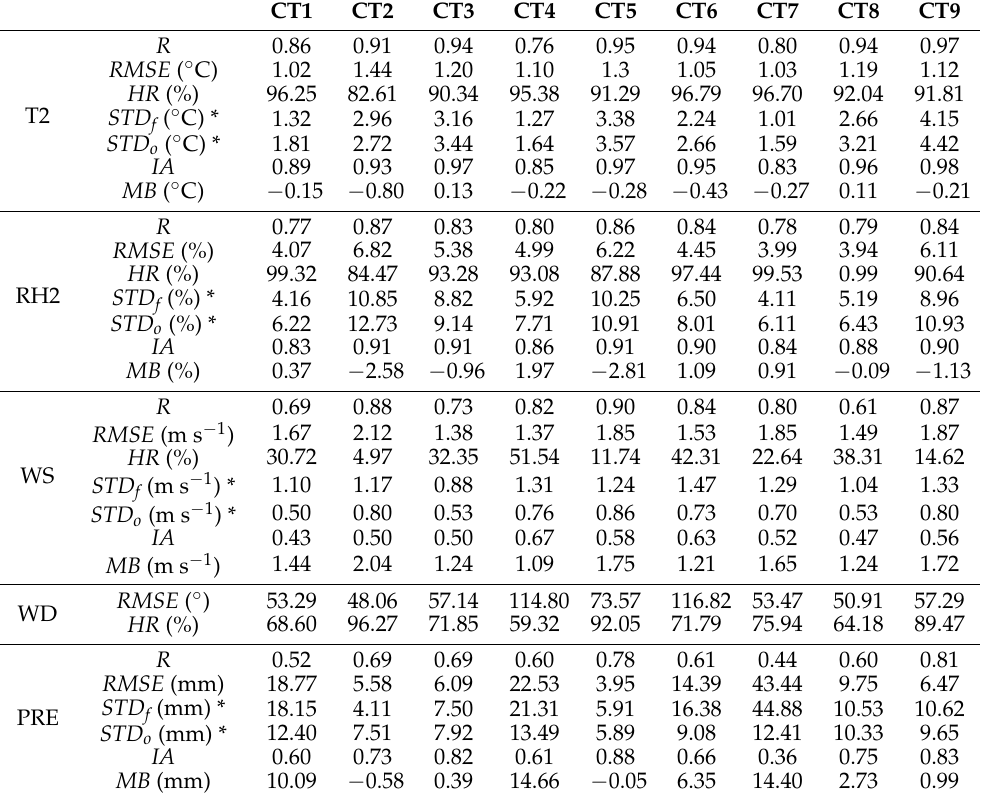
Table 7. Statistical indices for simulated and observed daily averaged T2, RH2, WS, WD, and PRE for different circulation